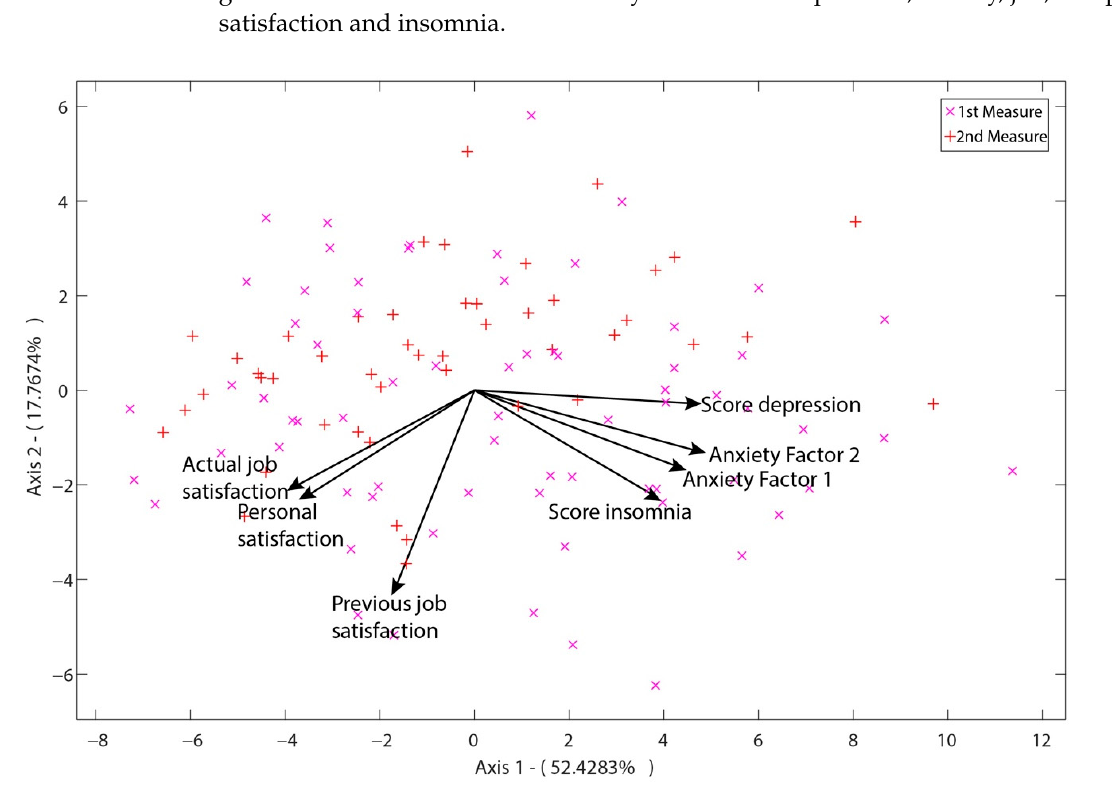
Figure 2. Two-dimensional representation of the HJ Biplot analysis using axes 1–2. Barycentric scaling. First measurement GR1 (x), second measurement GR2 (+).